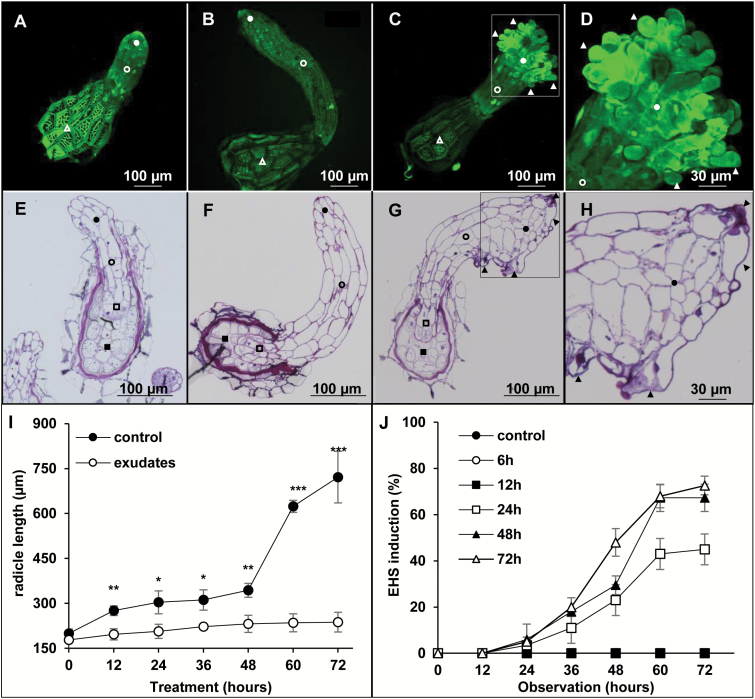

Brassica napus root exudates can trigger the formation of early haustorial structures in P. ramosa. (A–D) Confocal laser scanning microscope observation of P. ramosa germinated seeds stained with acridine orange. (E–H) Light microscope observation of thin sections of P. ramosa germinated seeds stained with toluidine blue. Open squares, embryo; filled squares, albumen; open circles, radicle; filled circles, apex; open triangles, testa; filled triangles, papillae. (A, E) Seeds before treatment. (B, F) Seeds incubated for 72 h in control buffer. (C, G) Seeds incubated for 72 h in half-diluted B. napus root exudates. Sale bars=100 µm. (D, H) Close-up view of the root apex of seeds incubated for 72 h in B. napus root exudates. Scale bars=30 µm. (I) Assessment of radicle length of P. ramosa germinated seeds upon treatment with B. napus root exudates during 72 h. Exudates were half diluted in buffer solution (0.5 mM HEPES, 0.05% PPM). The control condition corresponds to a treatment with the buffer solution alone. Means are values ±SE (n=6). Means annotated with asterisks are significantly different from the control points (t-test, *P<0.05, **P<0.01, and ***P<0.001). (J) Time course assessment of EHS development upon continuous treatment with B. napus root exudates for 6, 12, 24, 48, and 72 h, respectively. At the end of each treatment time, germinated seeds were rinsed, and exudates were discarded and replaced by buffer solution. Means are values ±SE (n=6).